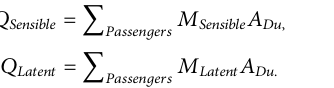
FIGURE 1 Metabolic heat load distribution vs. body mass (kg) and body height